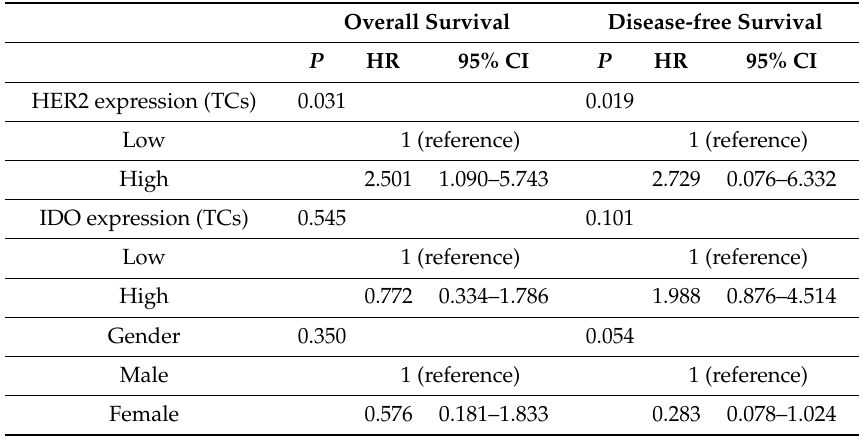
Table 4. Multivariate analysis of overall survival and disease-free survival in 69 patients with pathologic tumor stage pT2–pT4 urothelial carcinoma of the